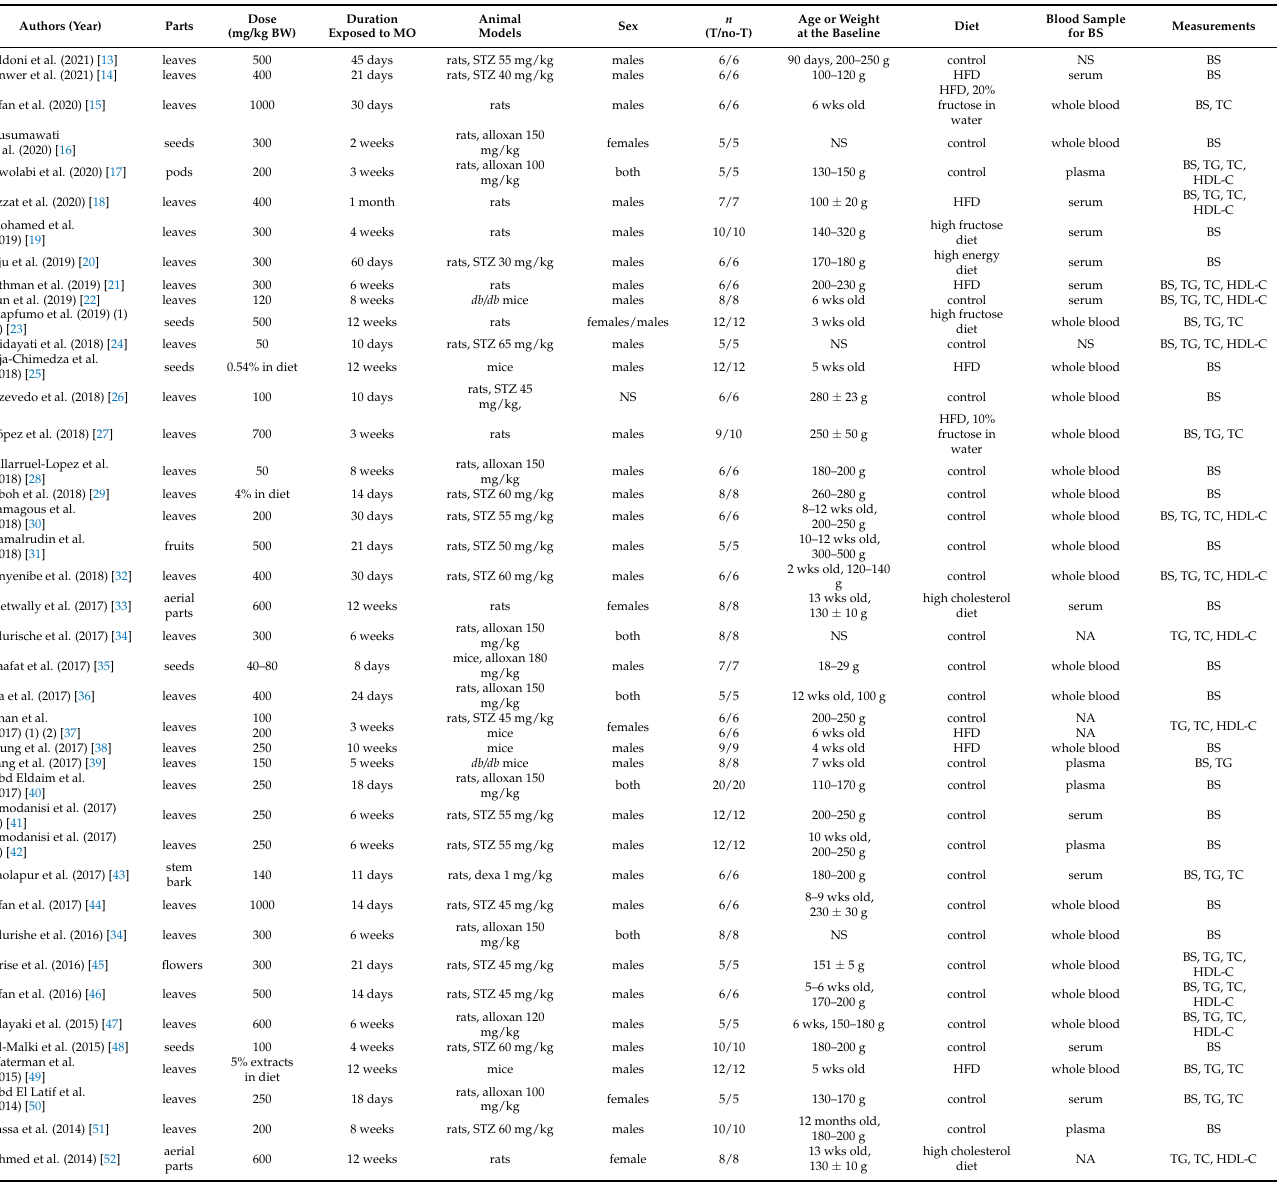
Table 1. Characteristics of included studies in the